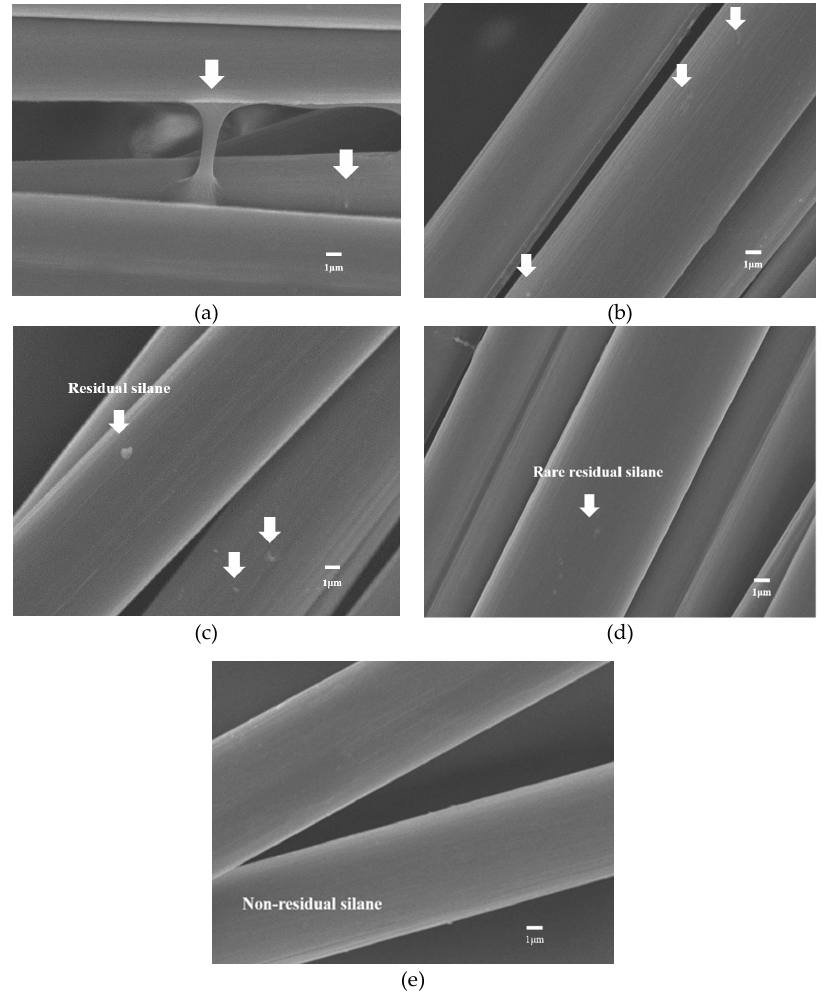
Figure 8. The SEM images of residual silane on short carbon fiber surface ( a ) unprocessed and using ( b ) water, ( c ) sodium hydroxide, ( d ) acetic acid, and ( e ) direct high-temperature heating.